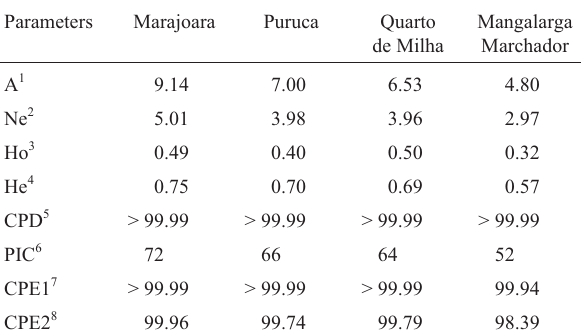
Table2 -Levelsofgeneticvariabilityandpercentagevaluesofgenealogi- cal parameters in Marajoara horses and Puruca ponies from the Marajó ar- chipelago in comparison with other breeds, based on 15 microsatellite markers from the ISAG panel control (Reis et al. , not